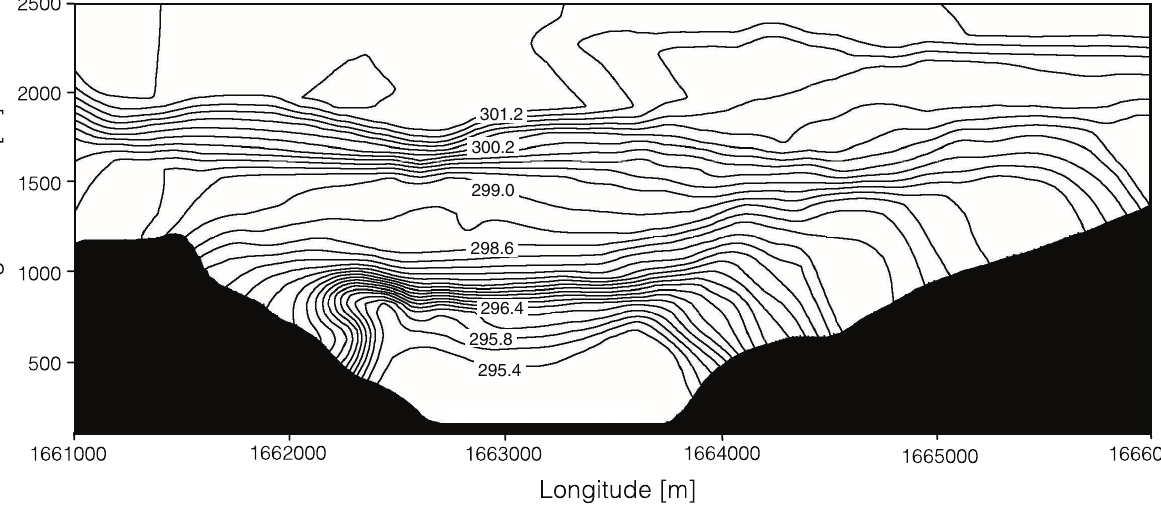
Fig. 10. Mapping of virtual potential temperature q measurements collected during the fl ight